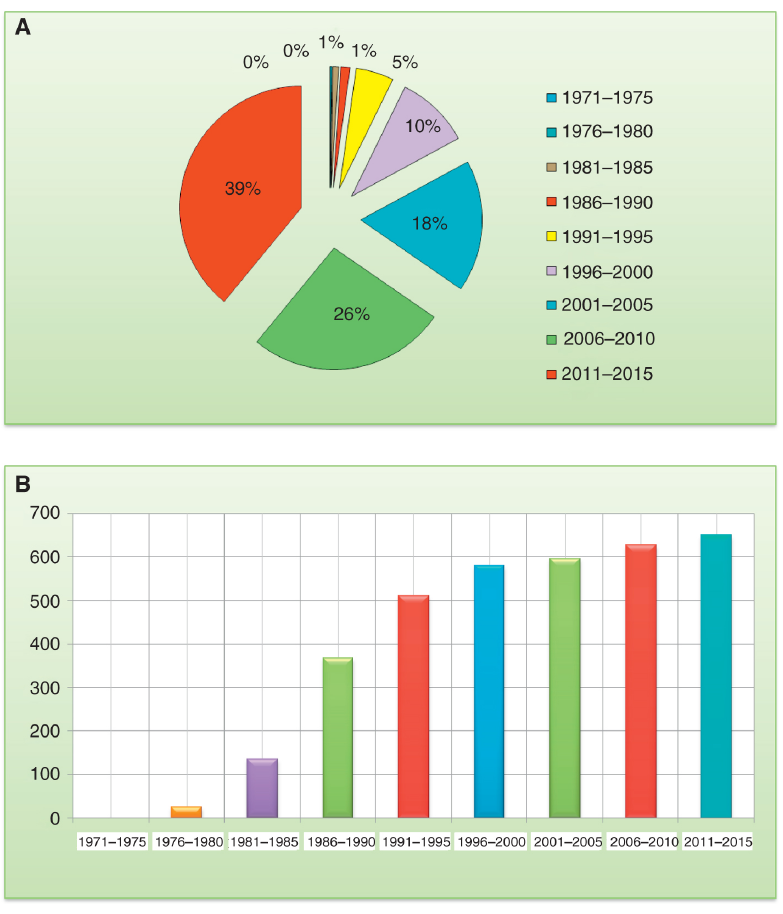
Figure 1: Trend in the application of experimental design methodologies in HPLC analysis of pharmaceuticals as evidenced in (A) Pubmed and (B) Scopus Search